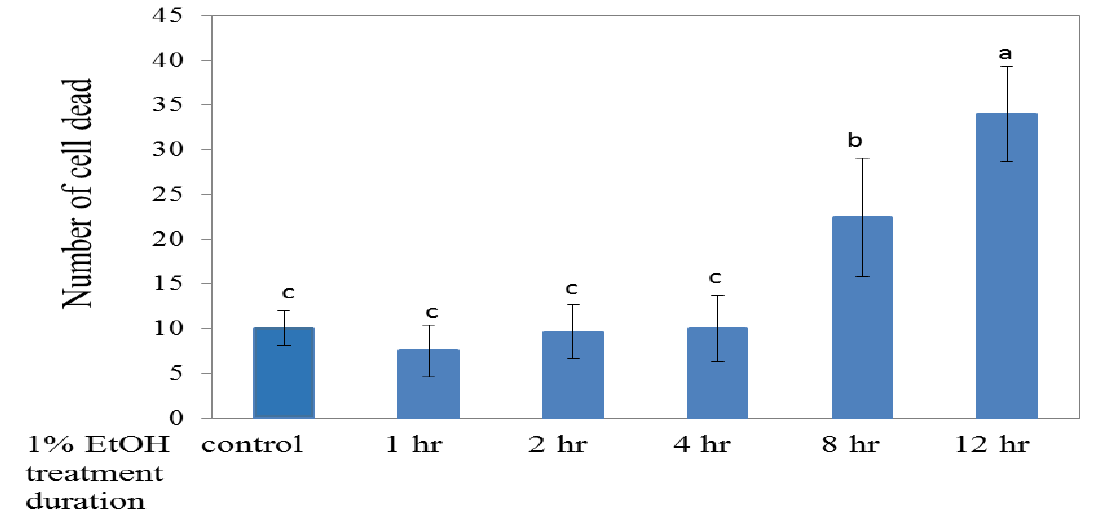
Figure 5. Effect of post-treatment with 200 ppm of HEEE on the cells of zebrafish embryos. The bar graphs represent the mean number of acridine orange-labeled cells, mean ± S.D.; n= 6 embryos. a–e The mean cell death values with different letters are significantly different for the different ethanol treatment times (p < 0.05). * The means of the cell death values with * are significantly different for the same ethanol treatment time (p < 0.05).